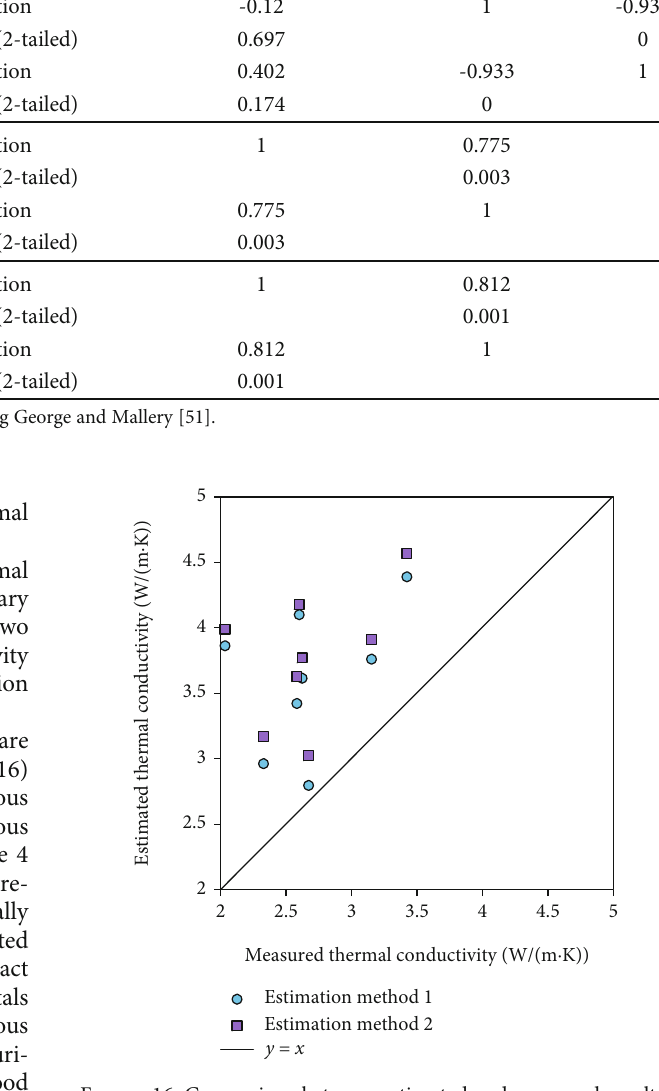
Figure 16: Comparison between estimated and measured